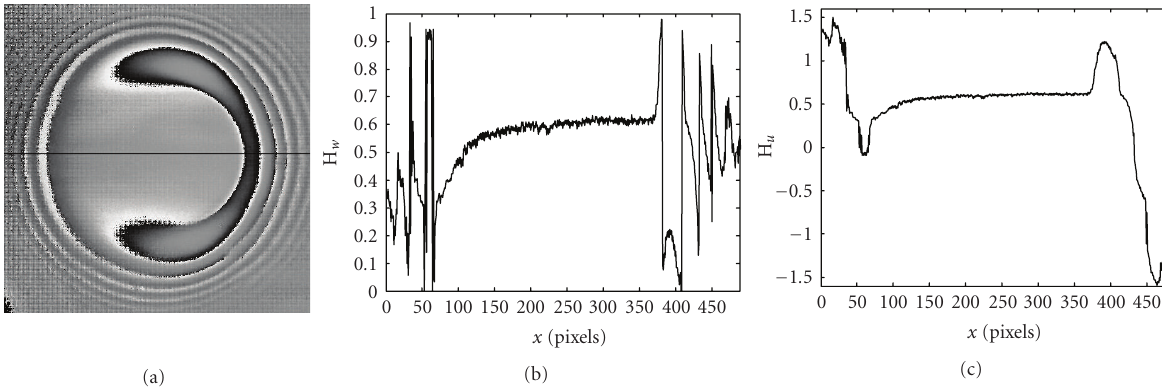
Figure 3: Wrapped phase map of a white light interferogram of an EHL point contact (a) and wrapped (b) and unwrapped (c) hue values along the horizontal line.